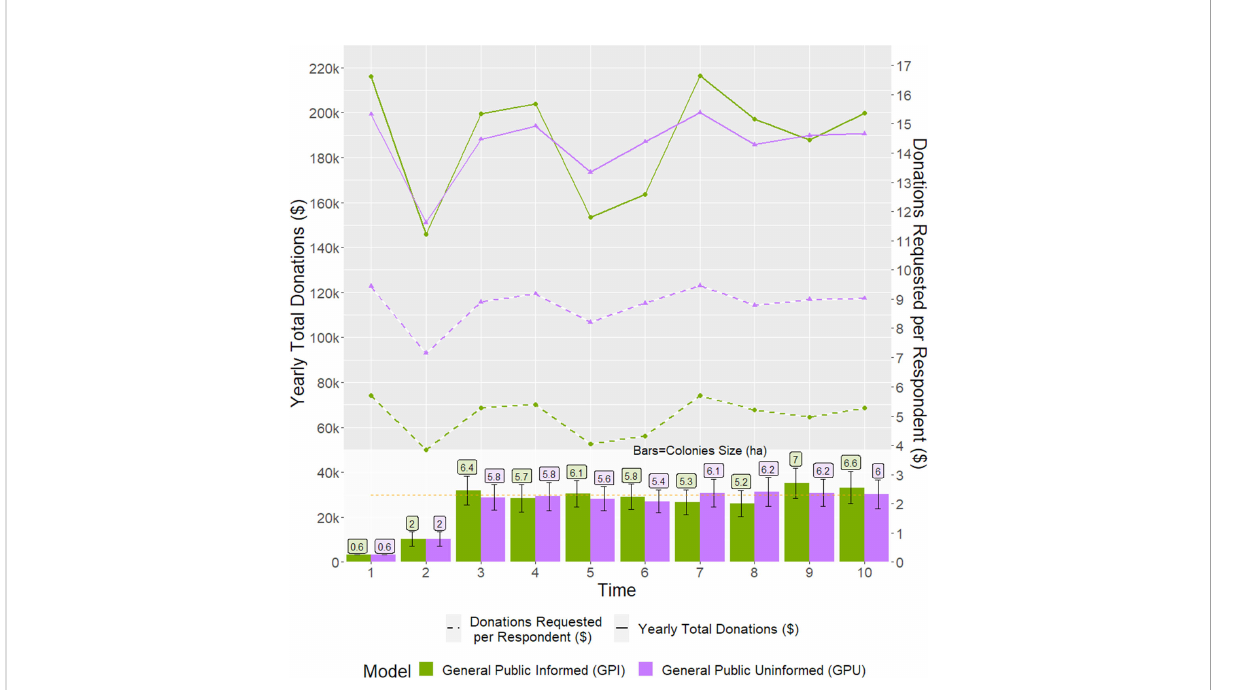
FIGURE 8 Total donations received (Lines, primary y-axis), as a result of an optimal donation request (Dashed lines, secondary y-axis) every year, as prescribed by the closed-loop model parameterized with either a General Public Informed (Purple) or General Public Uninformed (Green) behaviour model, and the resulting colonies ’ size